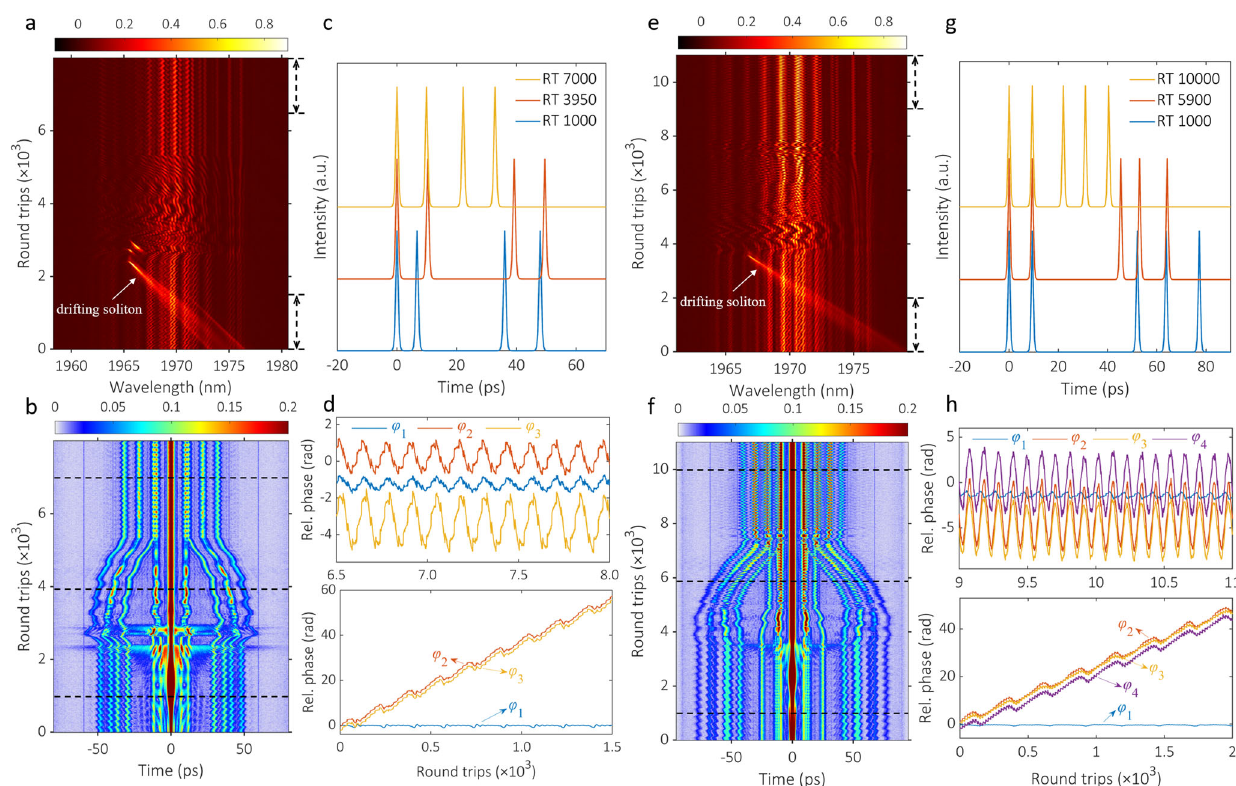
Fig. 3 Switching of oscillating soliton molecular complexes triggered by the collision of drifting soliton. a – d Switching of (2 + 2) oscillating soliton molecular complexes. a The real-time spectral evolution measured via DFT. b The corresponding fi eld autocorrelation traces. c The temporal pulse distribution of several typical RTs corresponding to the black dashed lines in ( b ). d Retrieved relative phase of soliton molecules corresponding to dashing lines in ( a ). e – h Switching of (2 + 3) oscillating soliton molecular complexes. e The real-time spectral evolution measured via DFT. f The corresponding fi eld autocorrelation traces. g The temporal pulse distribution of several typical RTs corresponding to the black dashed lines in ( f ). h Retrieved relative phase of soliton molecules corresponding to dashing lines in ( e